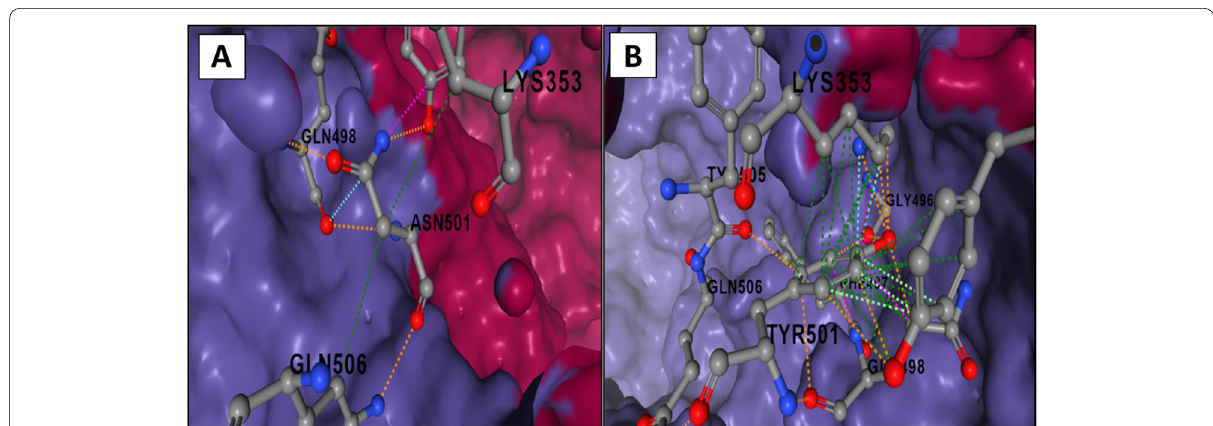
Fig. 1 Surface representation of the interaction interface between the a wild-type SARS-CoV-2 spike glycoprotein receptor-binding domain (RBD) and the human angiotensin-converting enzyme (hACE-2). b Interaction interface between the N501Y mutant SARS-CoV-2 spike glycoprotein RBD and the hACE-2. The blue and red-colored surfaces represent the SARS-CoV-2 spike glycoprotein RBD and the hACE-2 binding interfaces, respectively. The pink, cyan, red, green, and orange colored lines represent the clash, Van der Waals, hydrogen, hydrophobic, and polar bonds,